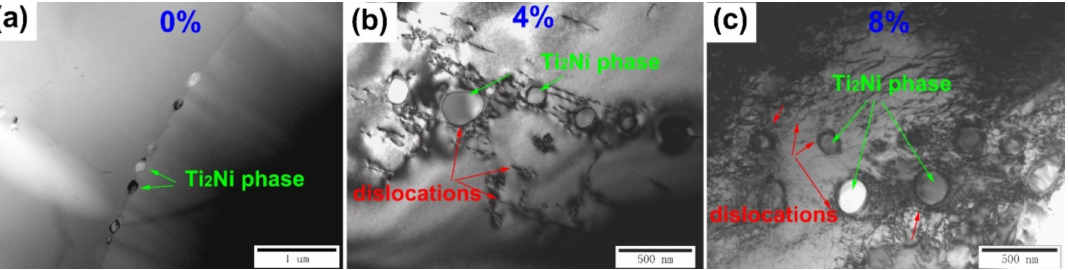
Figure 10. TEM bright-field images of ( a ) 0% compressive deformation, ( b ) 4% compressive deforma- tion, and ( c ) 8% compressive deformation